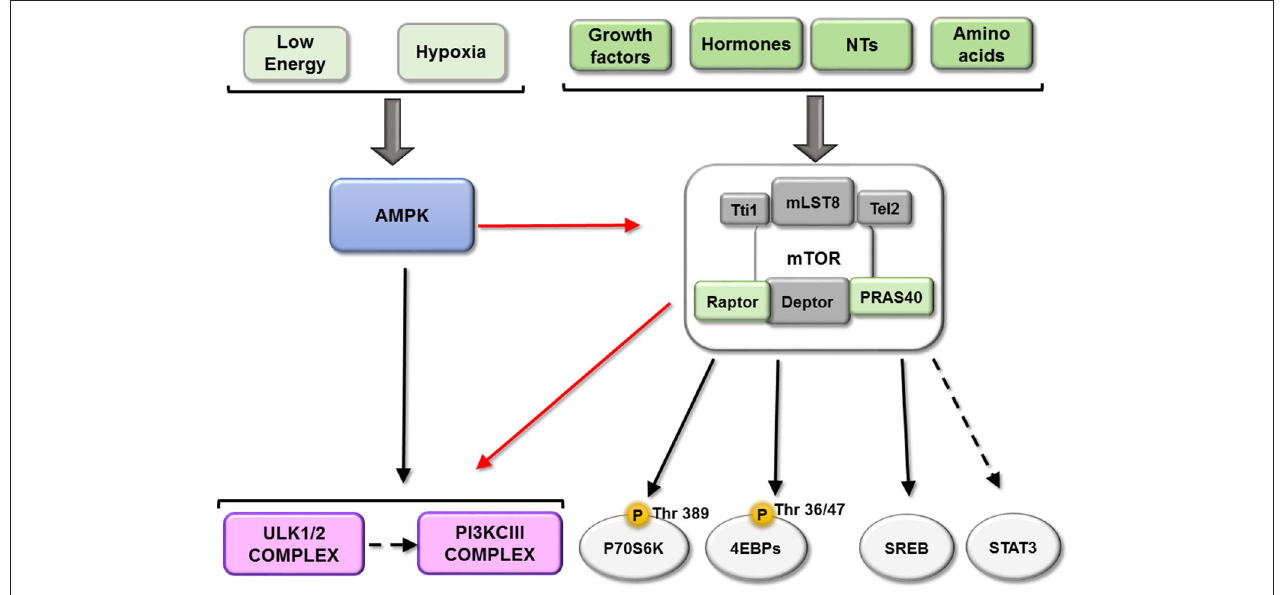
FIGURE 3 | Downstream of mTORC1. mTORC1 play a key role integrating information about the availability of some important metabolic factors. This figure represents the main mTORC1substrates described until now: P70S6K, EBPs, ULK complex and PI3KIII and their relationship. Black arrows represent activation and red arrows represent a